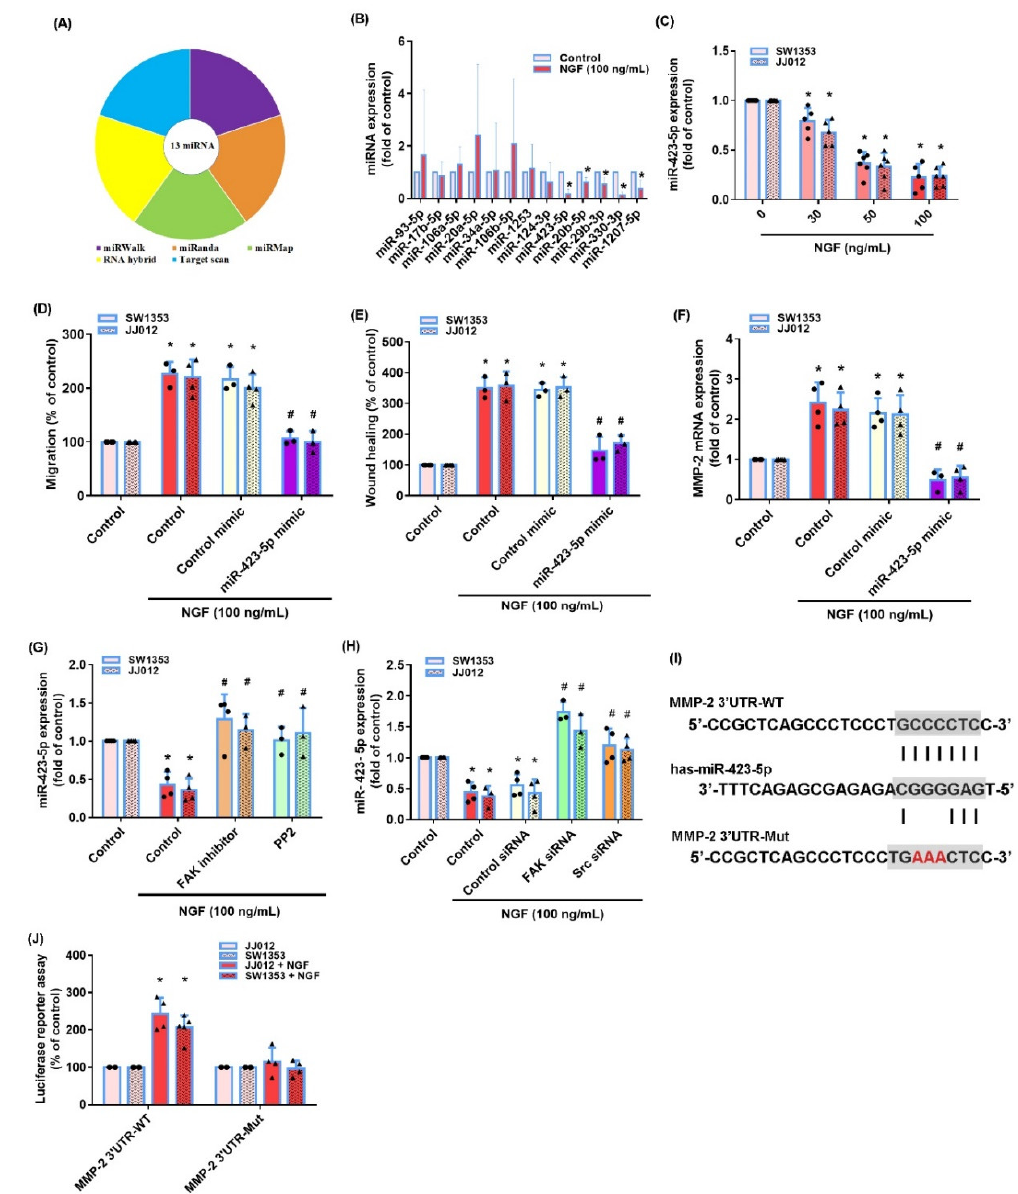
Figure 5. Inhibition of miR-423-5p mediates the NGF-induced stimulation of MMP-2 expression and the migratory activity of human chondrosarcoma cells. ( A , B ) MiRNA target prediction software was used to identify miRNAs that potentially bind to the MMP-2 3 (cid:48) -UTR. ( C ) SW1353 and JJ012 cells were incubated with NGF and miR-423-5p levels were examined by qPCR. ( D – F ) Cells were transfected with an miR-423-5p mimic then stimulated with NGF. The cell migration and MMP-2 expression levels were examined by Transwell, wound healing and qPCR. ( G , H ) Cells were pretreated with FAK and c-Src inhibitors or an siRNA and then stimulated with NGF prior to a qPCR analysis of the miR-423-5p levels. ( I ) The wild-type and mutant MMP-2 3 (cid:48) -UTRs contained the miR-423-5p binding site. ( J ) Cells were transfected with 3 (cid:48) -UTR plasmids as indicated then stimulated with NGF. The luciferase activity was examined. * p < 0.05 compared with the control group; # p < 0.05 compared with the NGF-treated